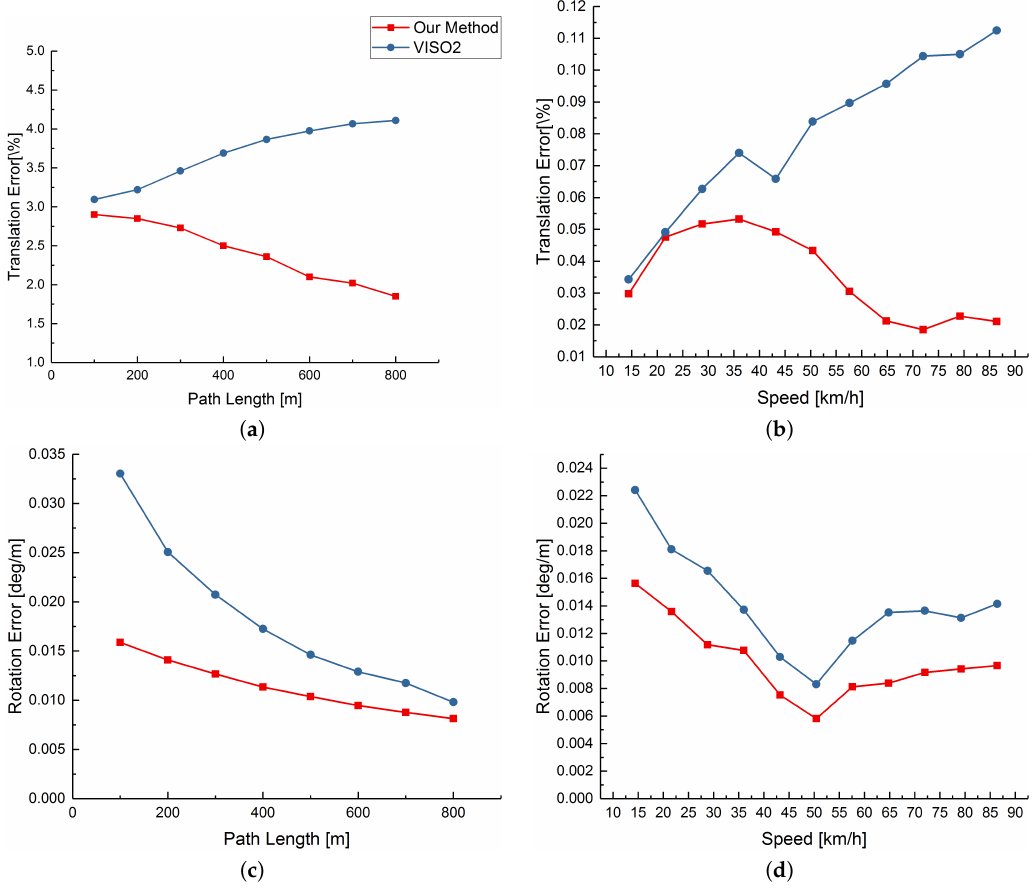
Figure 12. Average error on the KITTI dataset. Plots ( a , b ) refer to the average translation error for increasing path length and speed, respectively, while plots ( c , d ) refer to average rotation